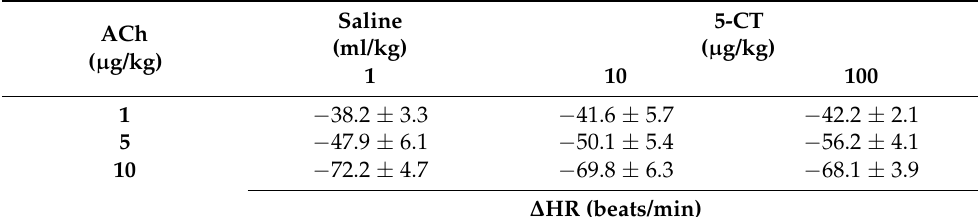
Table 3. Effect of 5-CT on the acetylcholine-induced bradycardia in fluoxetine-treated diabetic